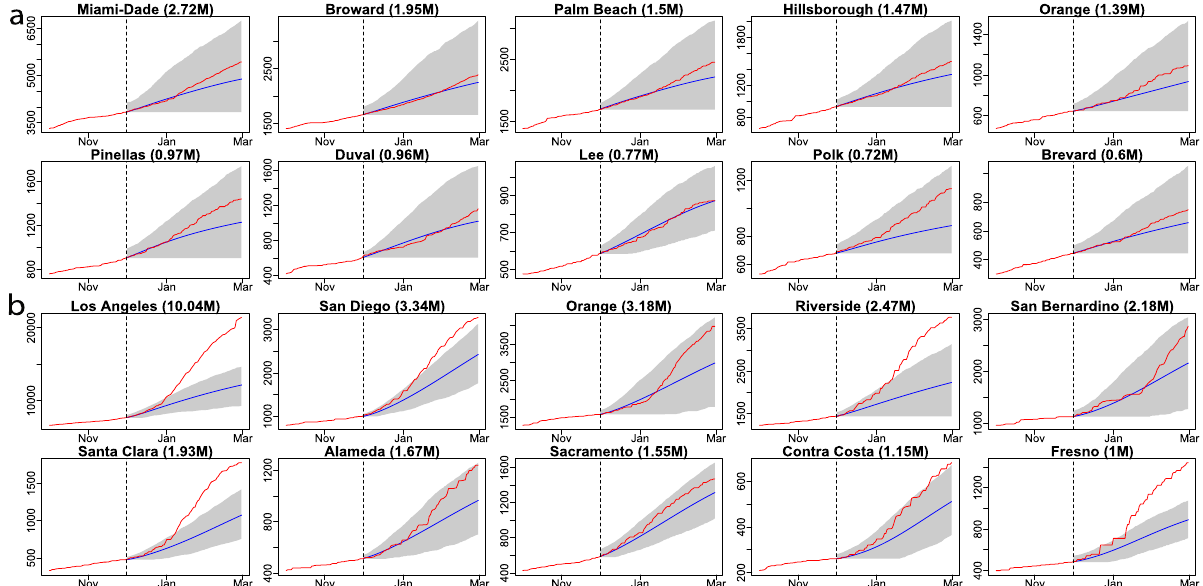
Figure 8. ( a ) The 90-day forecast in 10 counties with the largest population in Florida. The training period is from 21 March 2020 to 30 November 2020, whereas the forecast starts from 1 December 2020. The red curves are the cumulative observed death toll and the blue line indicates the forecast from 1 December 2020 to 28 February 2021. The shaded area represents the 95% predictive intervals of the forecast for each analyzed county in Florida. The numbers in the parentheses are the populations in million for each county. ( b ) the 90-day forecast in 10 counties with the largest population in California. The interpretations are the same as ( a